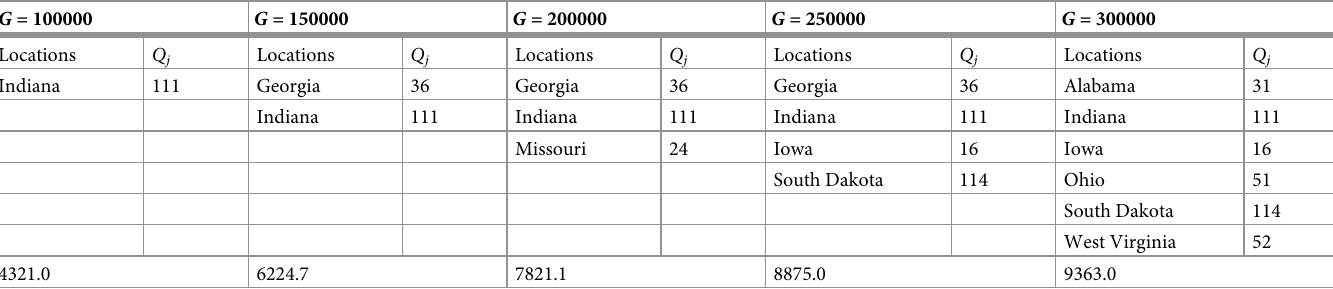
= 40, R = 80, δ = 100, γ 1 = 0.4, γ 2 = c q